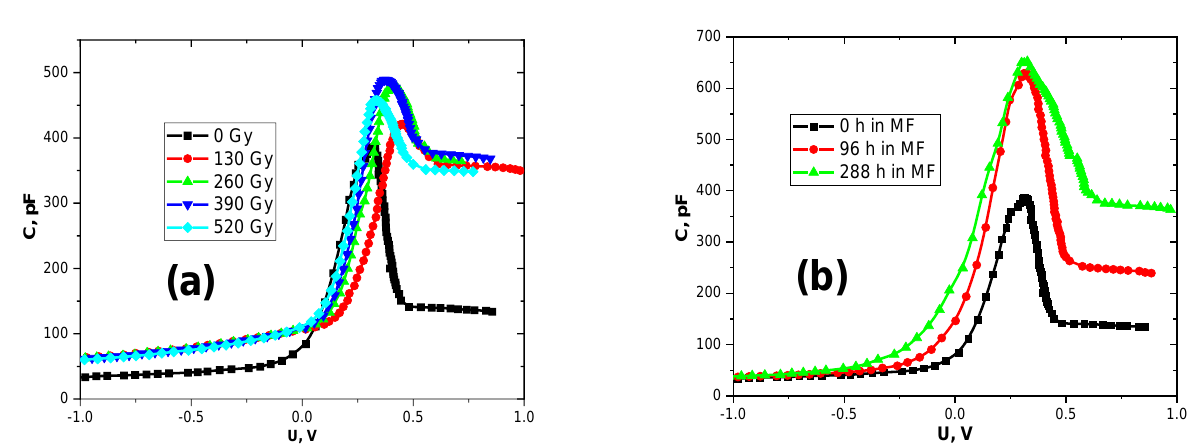
Figure 2. Radiative ( a ) and magnetic ( b ) stimulated changes of current–voltage characteristics in the Bi-Si-Al surface barrier structures.